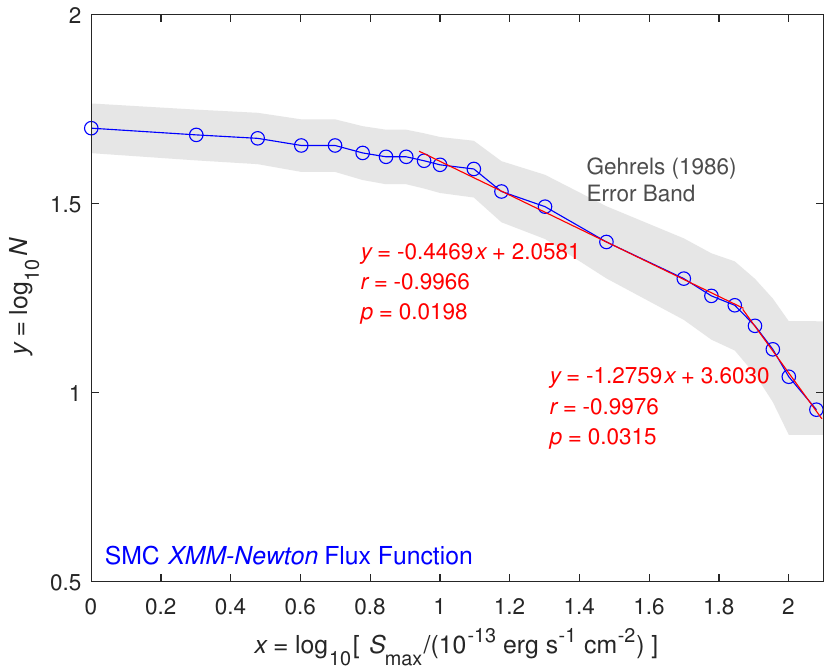
Figure 8. Cumulative number N of SMC XMM-Newton sources above a flux level S max versus S max on logarithmic scales (blue points). The grey area respresents the 1 σ error bars to the data points according to the prescription of [44]. The errors in the best-fit line are listed in Table